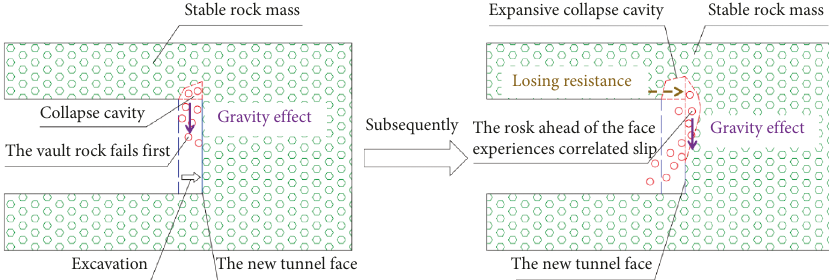
Figure 8: The instability mechanism of the tunnel face after tunnel